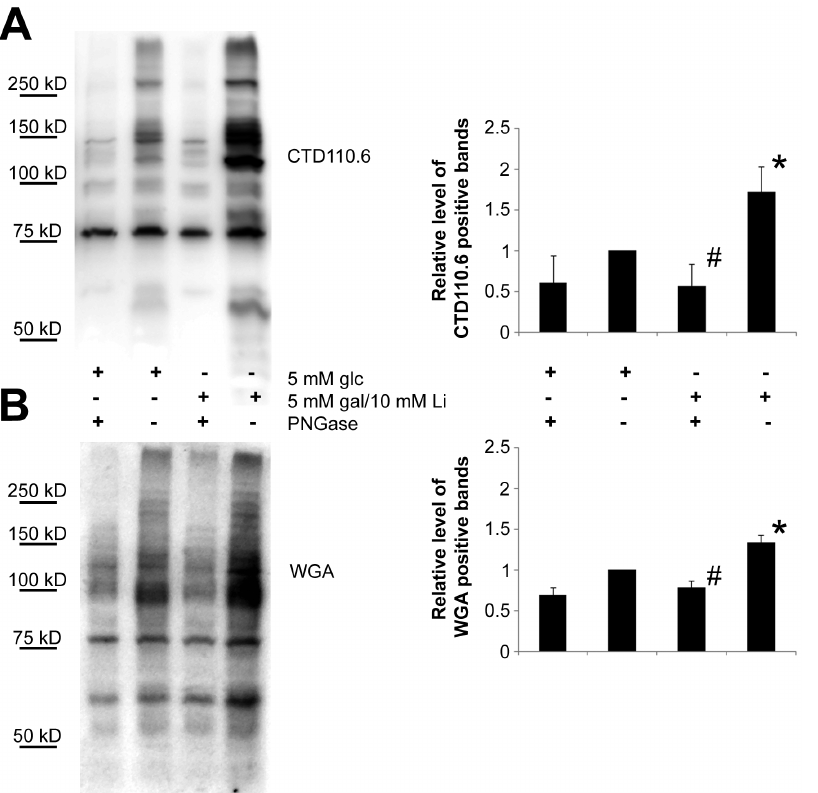
Figure 9. Enzymatically removing N-linked oligosaccharides disrupts elevated CTD110.6 signal in lithium treated, galactose-grown Jurkat cells. Western-blot analysis showing that CTD 110.6 antibody detects proteins with O-linked GlcNAc and Asn-linked GlcNAc. Western blot analysis showing protein extracts from cells kept in 5 mM glucose or 5 mM galactose and 10 mM lithium containing media for 48 hours. To remove all N-glycan moieties from the extracted proteins, each samples were also subjected to PNGase F digestion before loading. Following SDS-PAGE, PNGAse treated and non-treated samples were stained with either CTD110.6 antibody ( A ) or WGA ( B ). Right: Densitometric analysis of CTD110.6 or WGA positive bands. Relative levels are expressed as fold increase compared to the control, 5 mM glucose-grown cells. Data are means 6 SD from 3 independent experiments after normalized for total protein staining. *P , 0.05 vs. 5 mM glc, # P , 0.05 vs. 5 mM gal/10 mM Li.